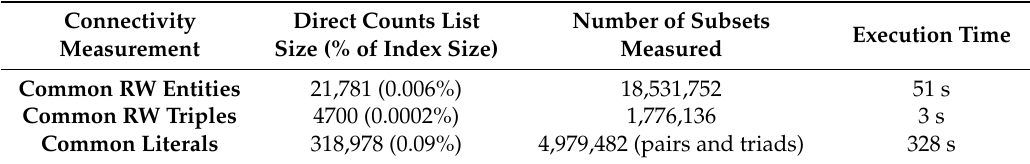
Table 7. Execution time for finding the commonalities for subsets of 400 RDF Datasets by using a “lattice”-based algorithm.